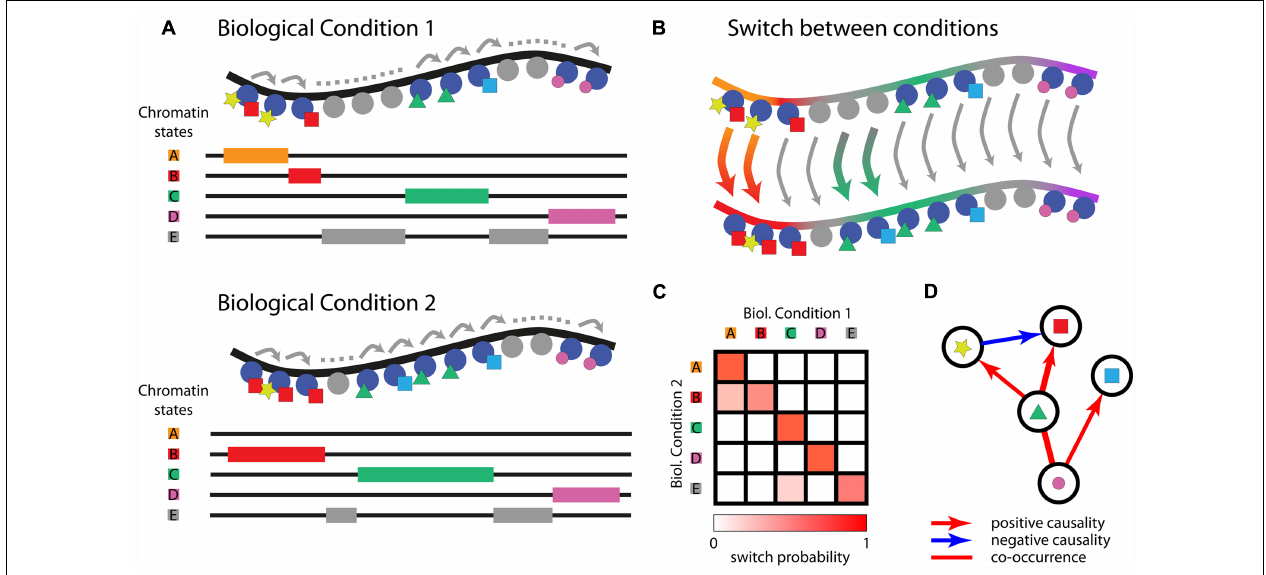
underlying diagram (A) . Chromatin states can be compared over different cell types or biological conditions; arrows represent the switch between different states (B) . Heatmap displaying the probability of switching between chromatin states in different biological conditions (C) . Graph depicting causal relationships among epigenetic marks determined based on (C,D)